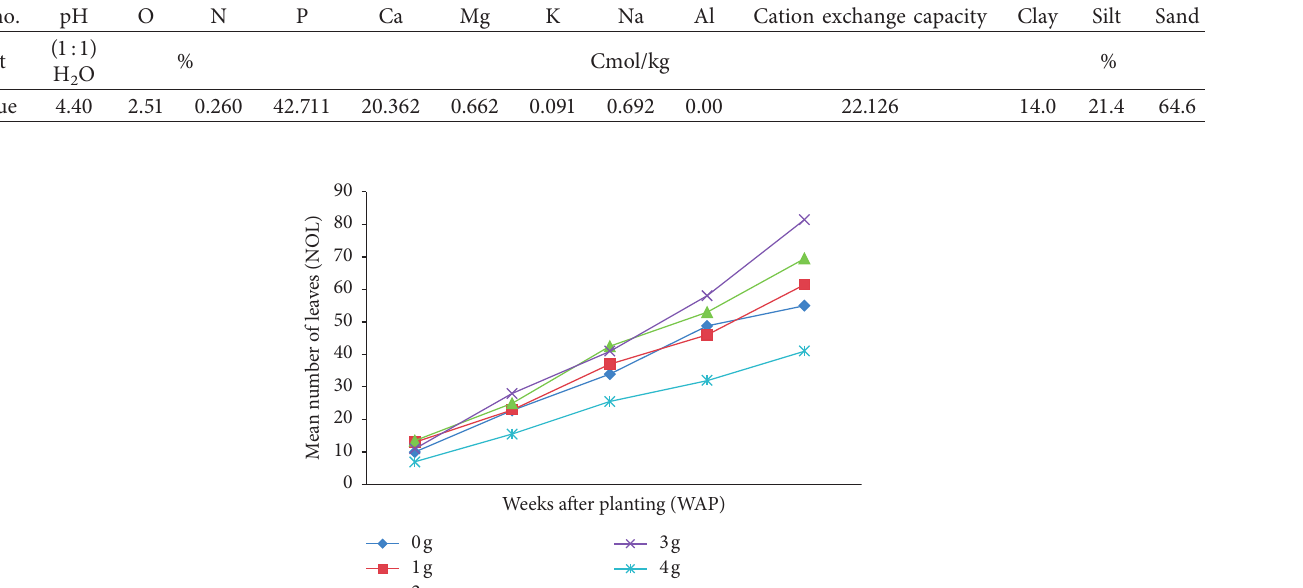
Table 1: Physicochemical characterization of the